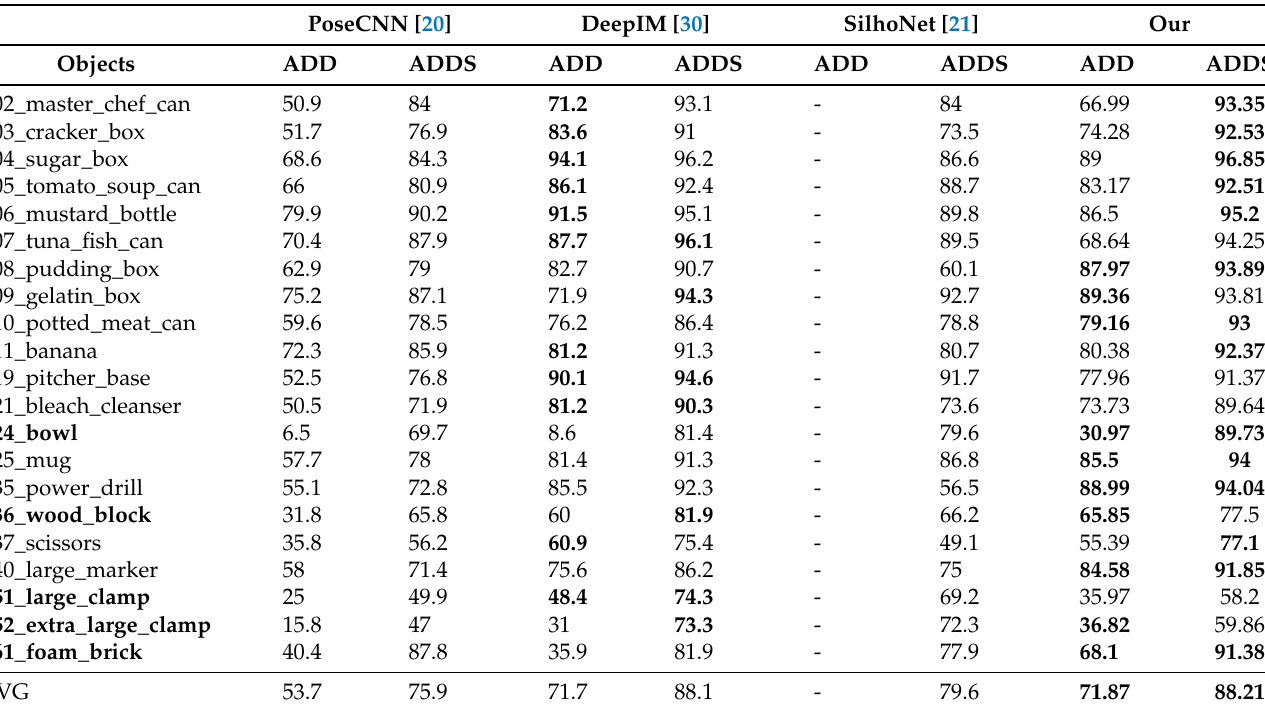
Table 2. Quantitative Evaluation of 6D Pose on the YCB-Video Dataset. Objects in bold are symmetric. PoseCNN [20] DeepIM [30] SilhoNet [21] Our